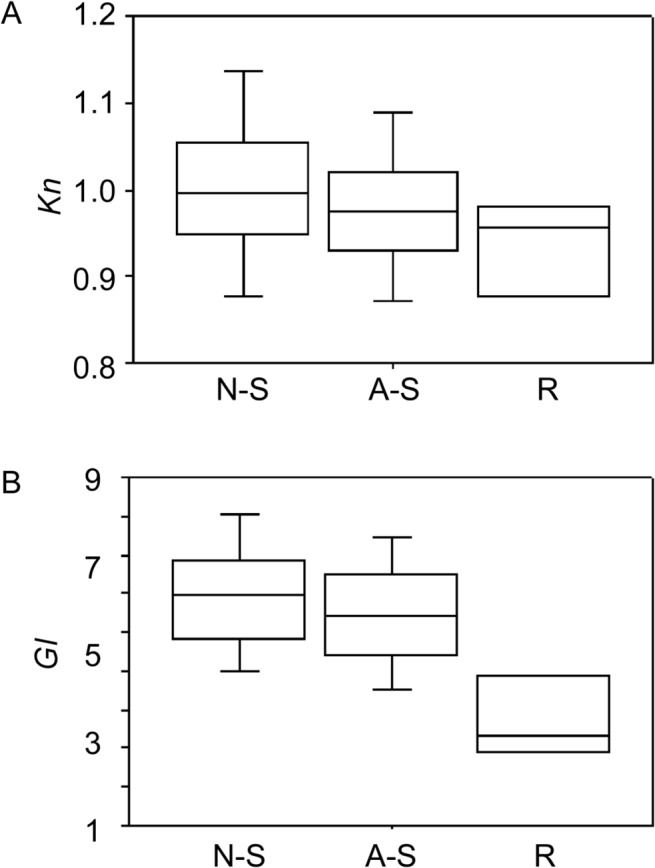
Variation in relative condition factor (Kn) (A) and gonad index (GI) (B) with reproductive phase.N-S = non-spawning, A-S = actively spawning, and R = regressing. Females with hydrated oocytes were excluded from the GI analysis. The box represents the median and interquartile range, and the vertical lines represent the 95% confidence interval for the median.